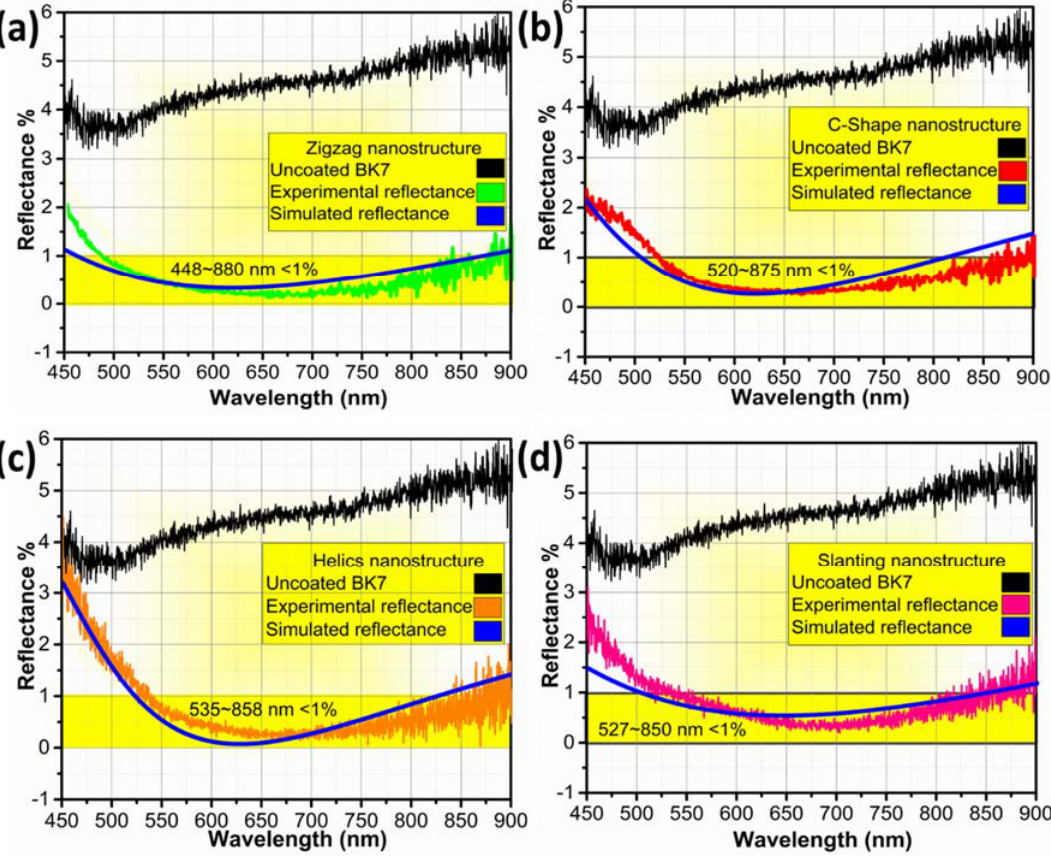
Figure 5. Bilayer SiO 2 AR coating efficiency on BK7 substrate: ( a ) nanozigzag, ( b ) C ‐ shape, ( c ) nanohelix, and ( d ) slanting nanostructures. Blue curves represent the simulated reflectance of design coating. The black curve represents reflectance from the uncoated substrate. Coloured curves represent the experimentally measured reflectance results of fabricated bilayer SiO 2 AR coatings.